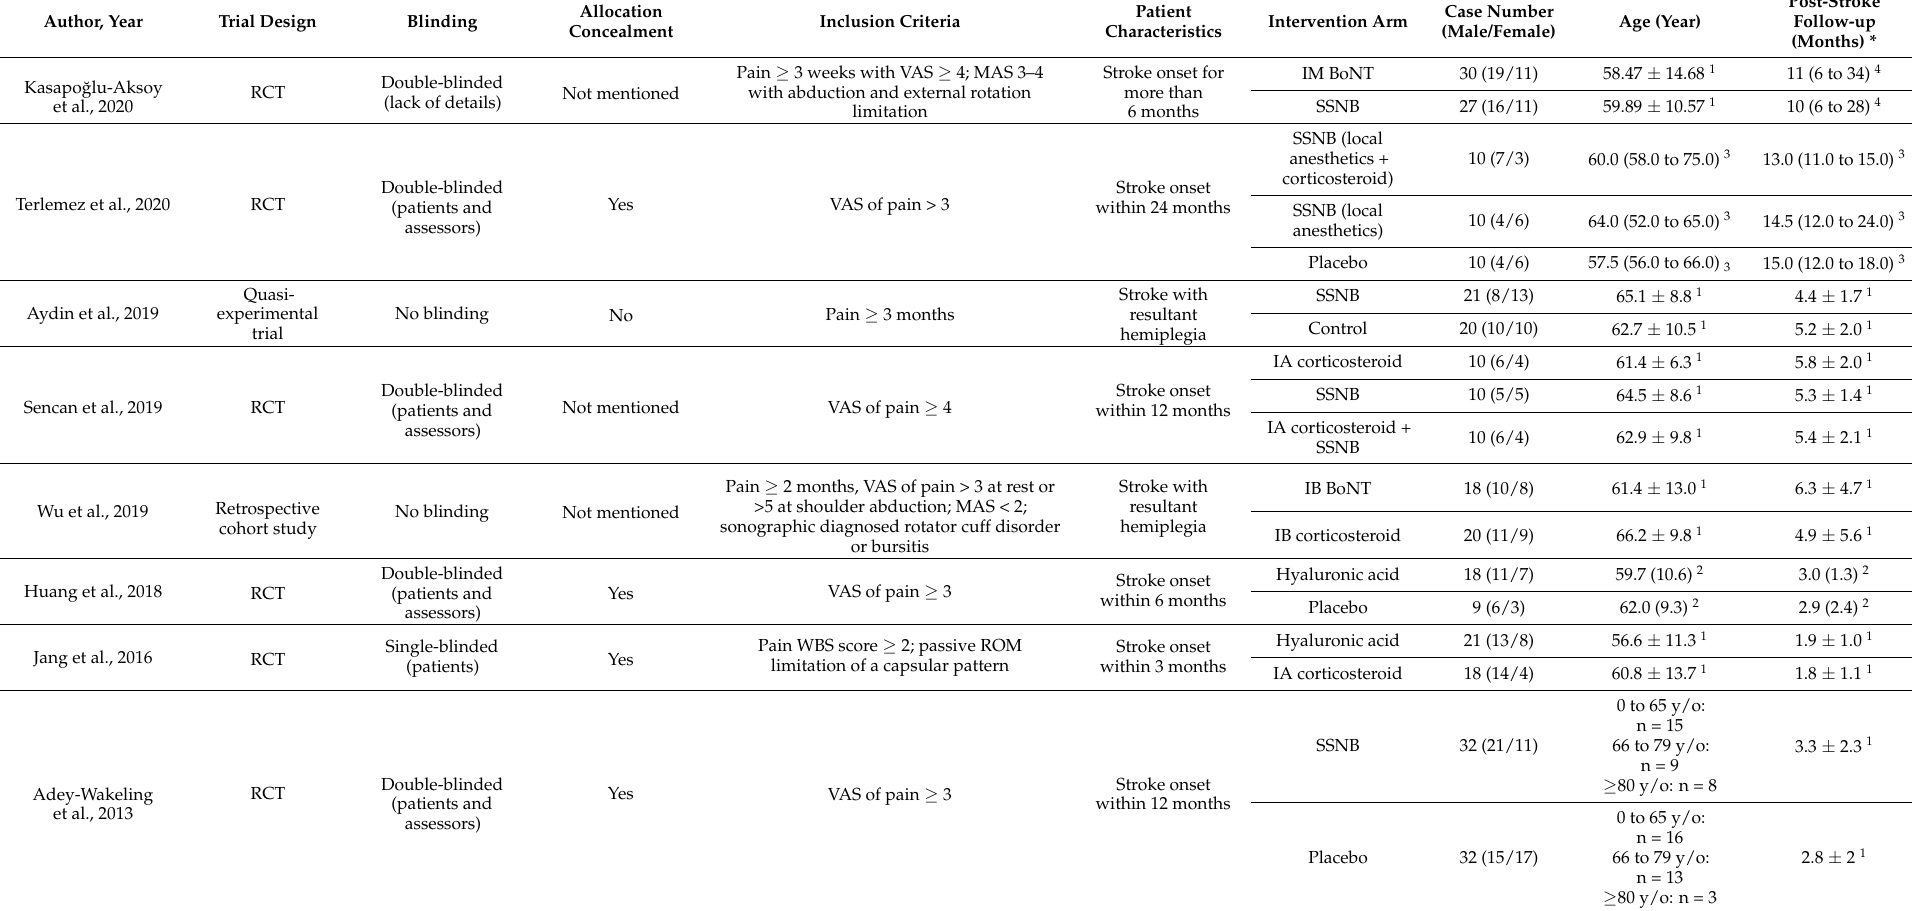
Table 1. Summary of the retrieved trials investigating the injection therapies for hemiplegic shoulder pain due to